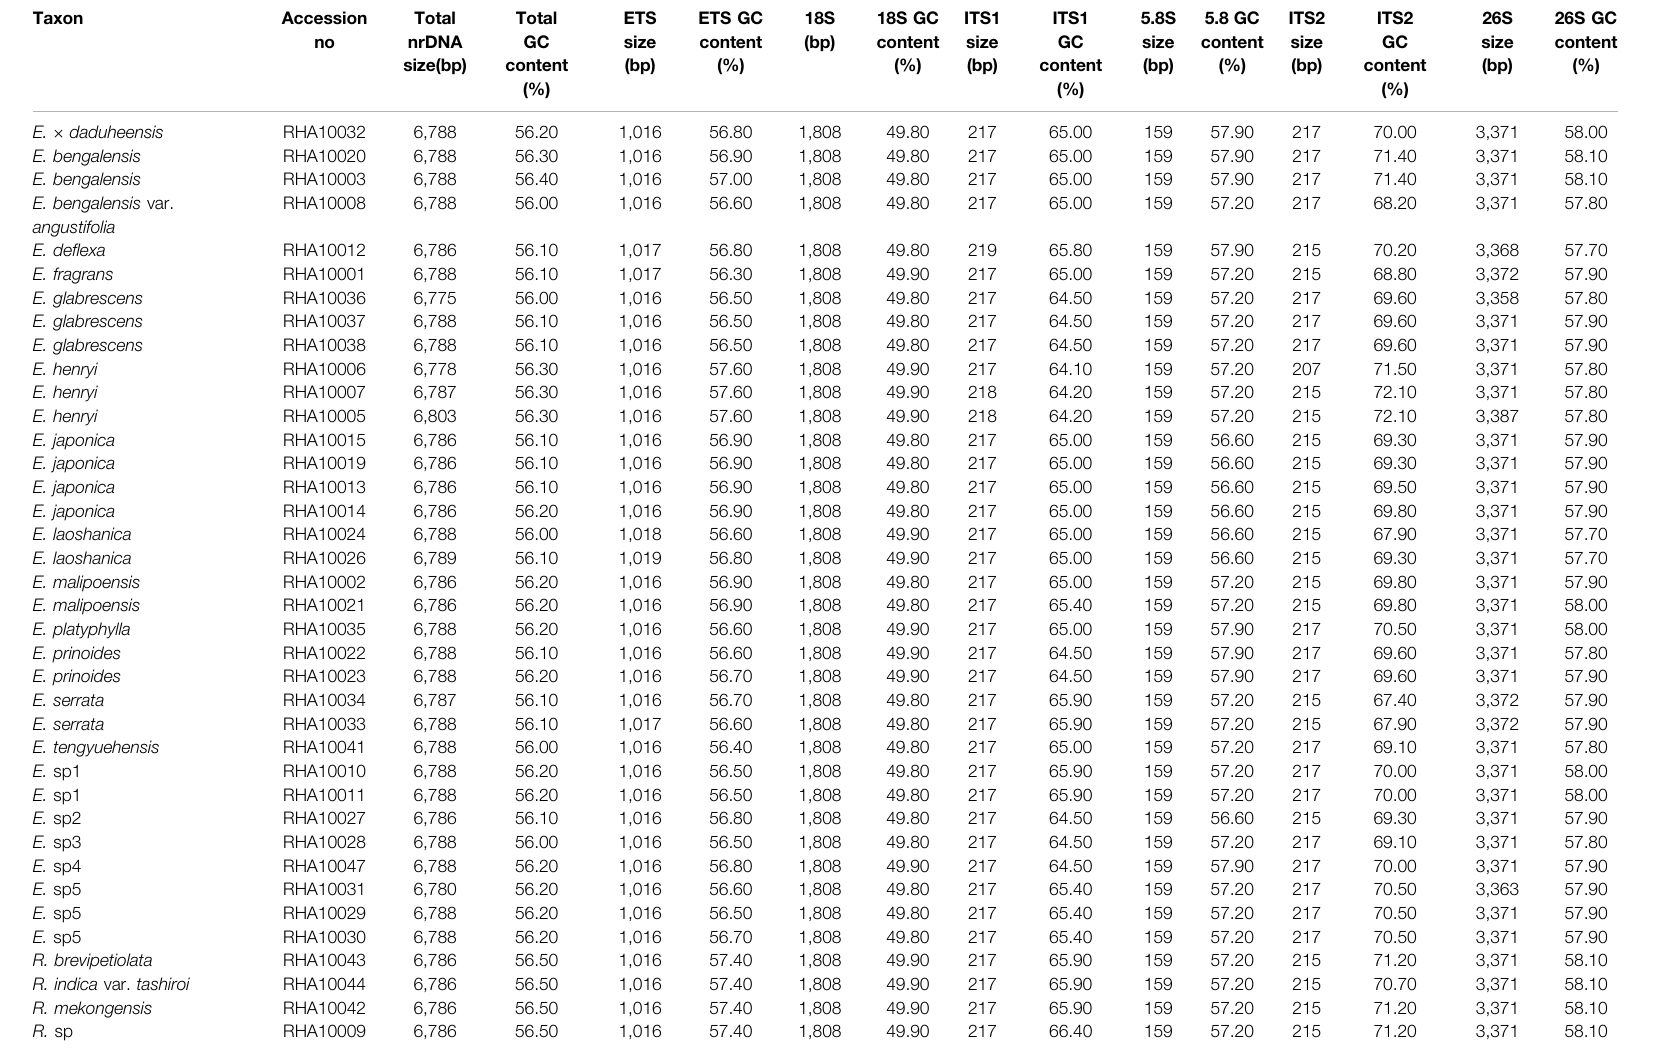
TABLE 2 | Summary of 38 nrDNA of Eriobotrya and Rhaphiolepis